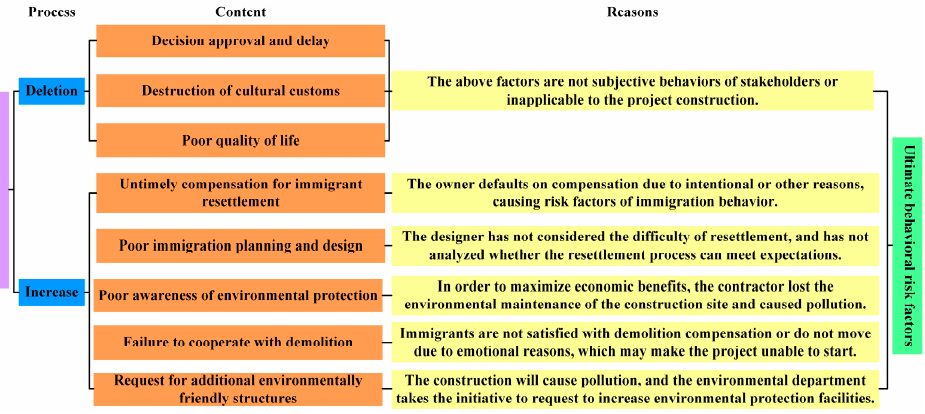
Figure 3. Behavioral Risk Factor Identification Process.